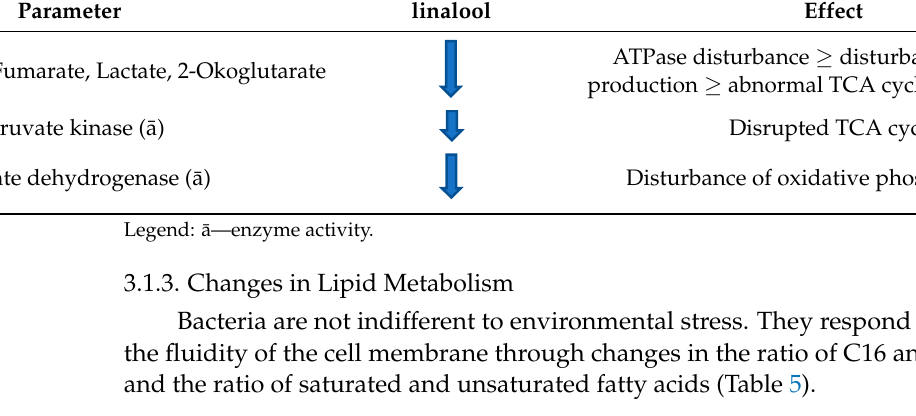
Table 5. Effect of linalool on lipid metabolism.